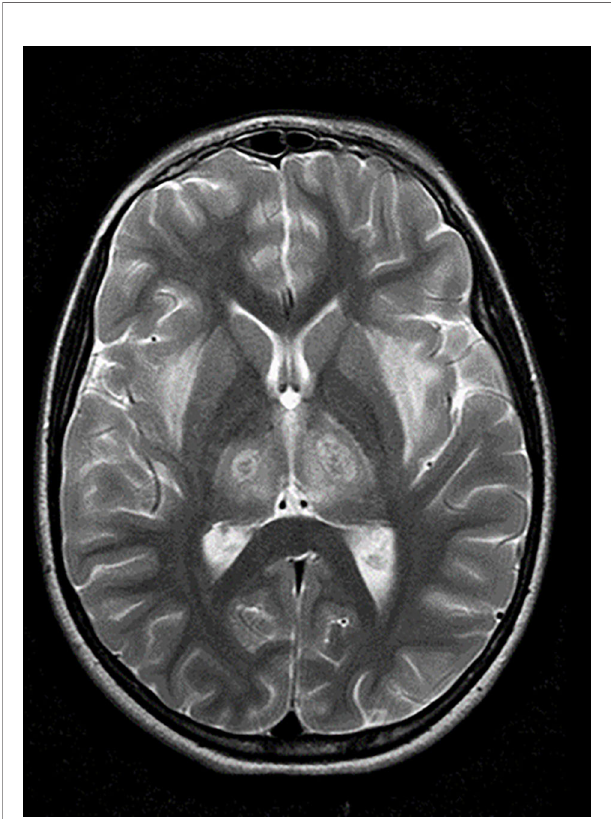
FIGURE 1 | Acute Necrotizing Encephalopathy (Local case). (Personal case of APN and JMW): Axial T-2 weighted MRI of a 9-year-old girl with who presented with classical clinical features of ANE and was admitted to the local paediatric intensive care unit. The MRI shows the classical symmetrical involvement of both thalami (with a target appearance) and symmetrical external capsular white matter affected. She had brainstem involvement (not shown) and was treated with intravenous methylprednisolone early. She survived with mild to moderate neurological sequelae. She was the fi rst in her family to be genetically con fi rmed as positive for a RANBP2 mutation, with two of her cousins having been previously affected. The genetic result assisted with identi fi cation of at-risk family members, counseling and subsequent preventative measures including vaccination and early ANE ‘ crisis ’